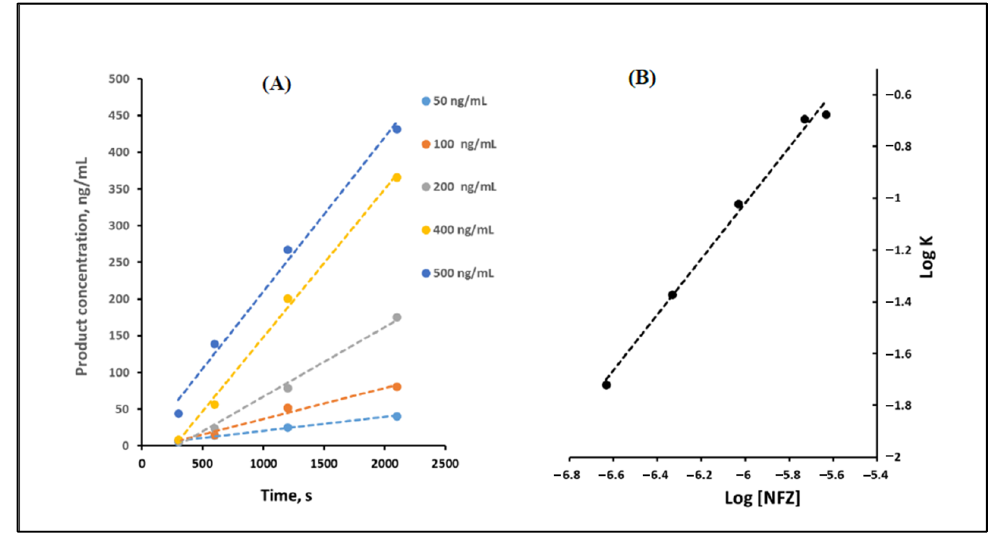
Figure 6. ( A ) Product concentration (ng/mL) versus time (seconds) curve for increasing concentra- tions of NFZ, and ( B ) log K versus log [NFZ] curve.